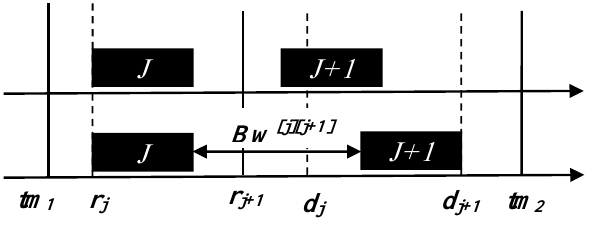
Fig. 2. Graphic representation of Basic